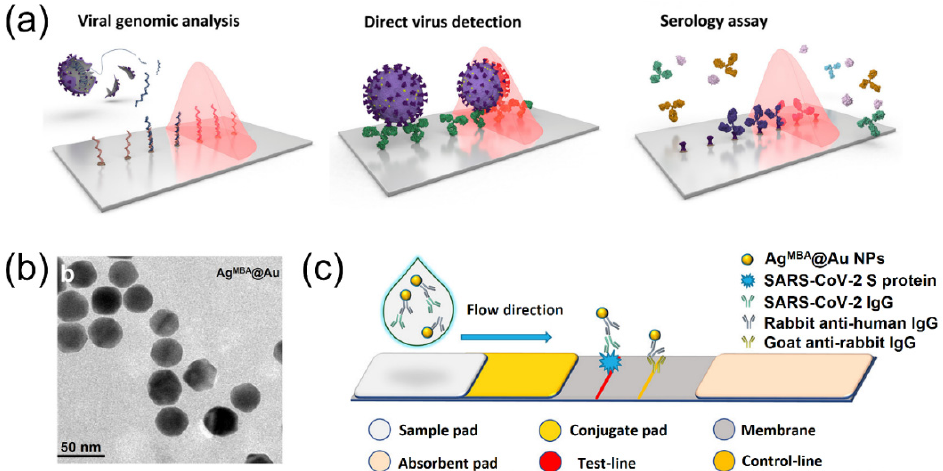
Figure 4. Responsive photonic crystals and plasmonic nanostructures for COVID-19 biosensing. ( a ) Schematic illustration of the virus biosensing and detection. Reprinted from [94], with permission from the American Chemical Society. ( b ) TEM image of the Ag@Au nanoparticles for biosensing of SARS-CoV-2 IgG. ( c ) Schematic illustration of detection principle of a test strip. Reprinted from [105], with permission from American Chemical Society.